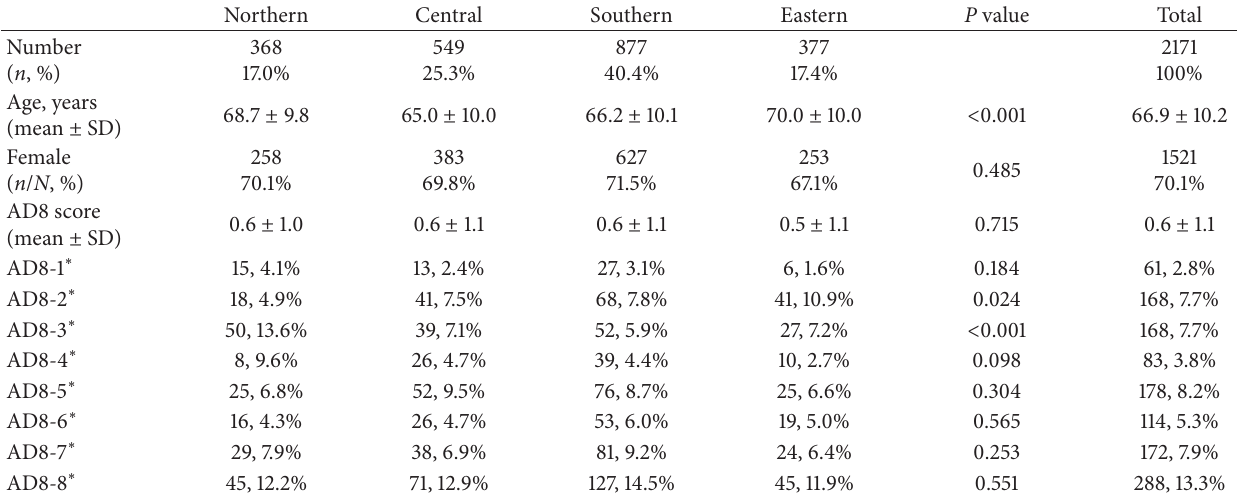
Table 1: Demographic characteristics of all recruited participants.